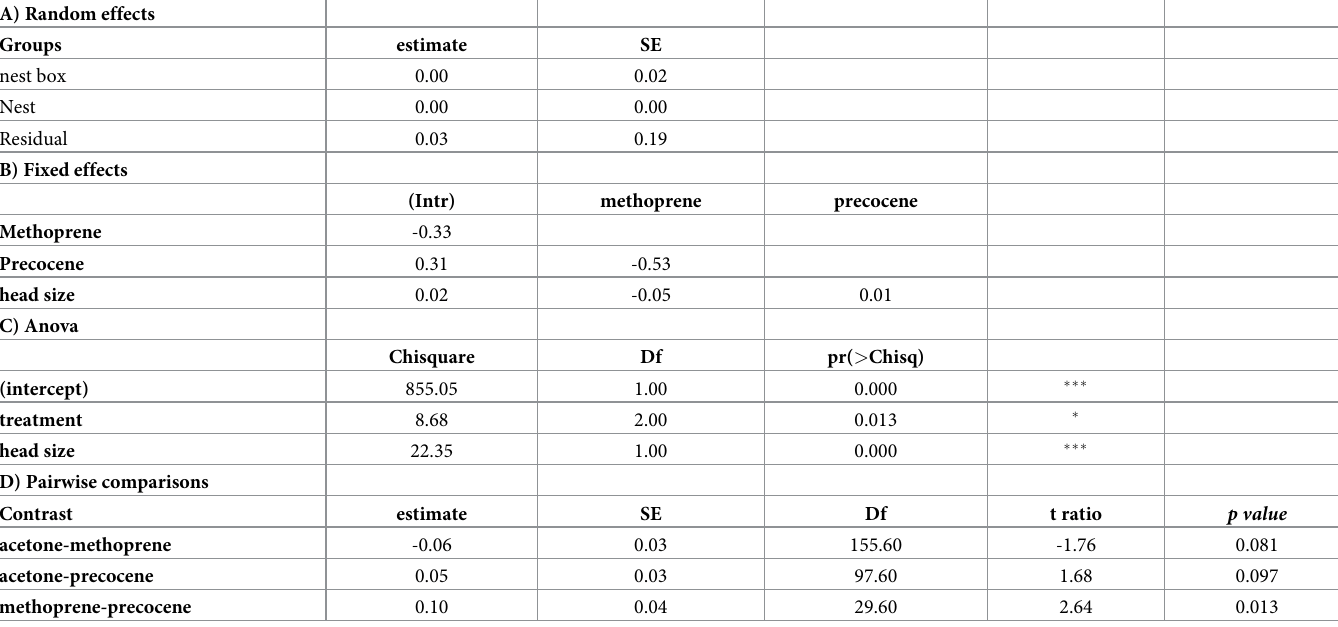
Table 1. Oocyte size across hormonal treatments in Vespula vulgaris workers compared using a general linear mixed model (GLMM) with treatment and head size included as fixed effects and nest and nestbox coded as random factors. A) Random effects